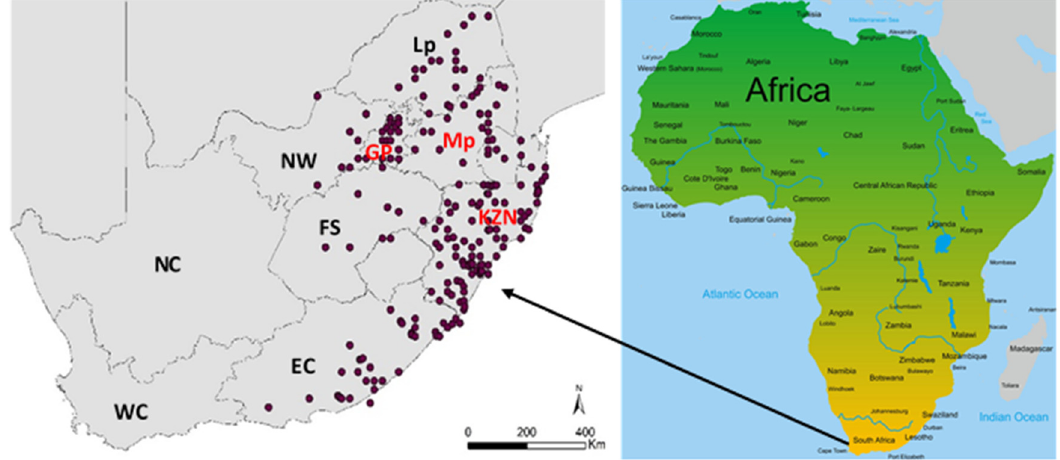
Figure 4. Distribution of Hypoxis hemerocallidea in South Africa, showing no records in Northern (NC) and Western Cape (WC) Provinces (Source: South African National Biodiversity Institute; SANBI). Provinces: WC: Western Cape; NC: Northern Cape; EC: Eastern Cape; FS: Free State; NW: North West; GP: Gauteng; KZN: KwaZulu-Natal; Mp: Mpumalanga; Lp: Limpopo.